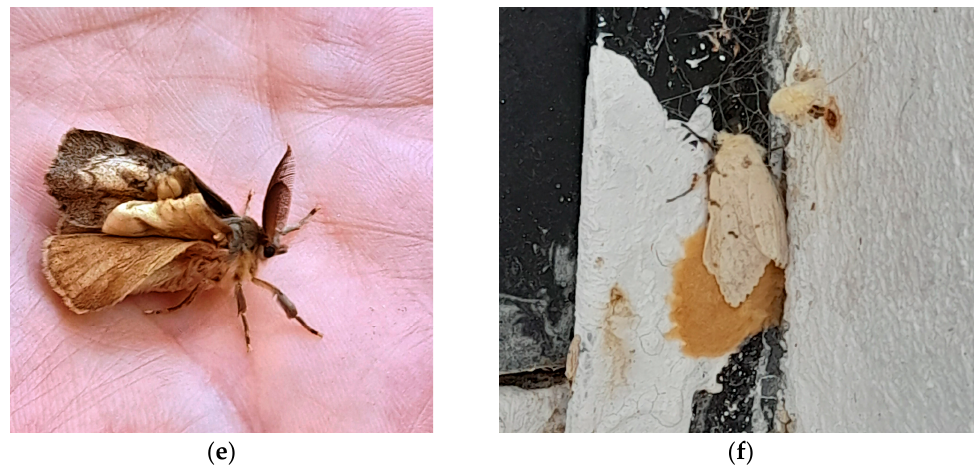
Figure 1. ( a ) Severe defoliation of oak by Lymantria dispar . ( b ) Egg clusters of L. dispar . ( c ) Late instar larva of L. dispar . ( d ) Pupa of L. dispar . ( e ) Newly emerged adult male of L. dispar . ( f ) Female of L. dispar laying eggs on a wall.